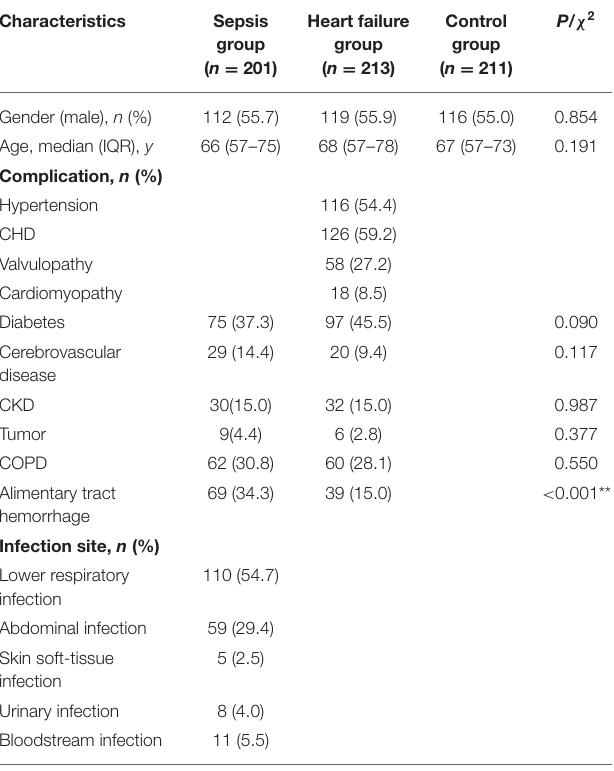
TABLE 2 | Multiple comparisons of cardiac indicators among the sepsis group, the HF group, and the control group. Variables